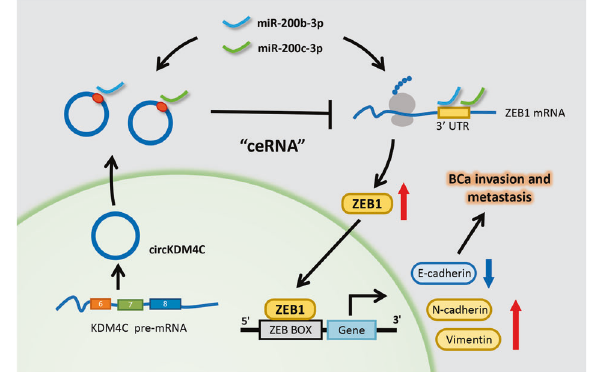
Fig. 6 Schematic presentation of the circKDM4C-regulated path- way in BCa cells. circKDM4C derives from the KDM4C gene and consists of the exon 6 – 8. circKDM4C possesses miR-200bc-3p binding site and could directly sponge miR-200b-3p/miR-200c-3p to indirectly increase ZEB1 expression, which promotes bladder cancer invasion and metastasis